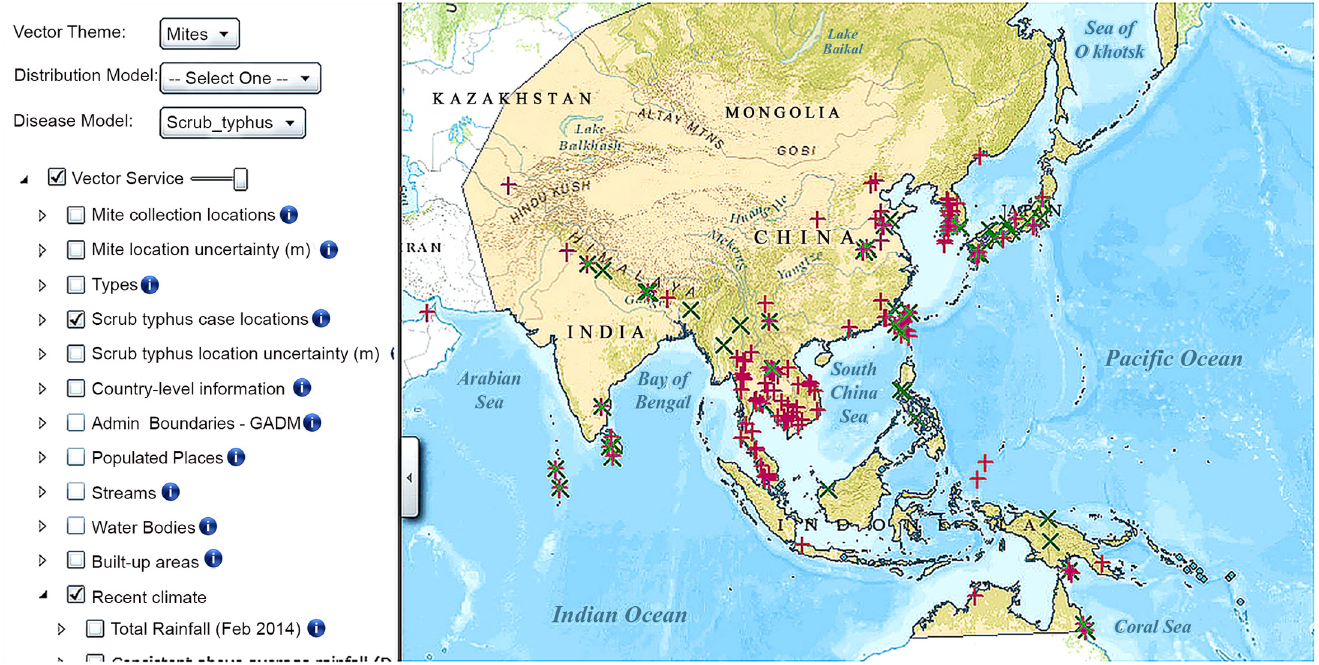
Fig 5. Opening screen of the scrub typhus VectorMap web application showing scrub typhus cases. Map area in orange shows traditional endemic area [18]; red “ + ” indicates site of confirmed cases, green “ x ” indicates site of probable cases, blue dots indicate serosurveys of scrub typhus positive sites.